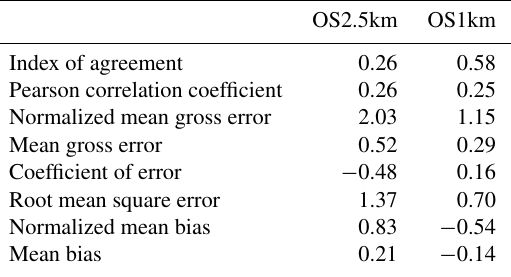
Table 8. Standard performance evaluation of Flight 17 for NO 2 (ppbv, 1174 model–observation